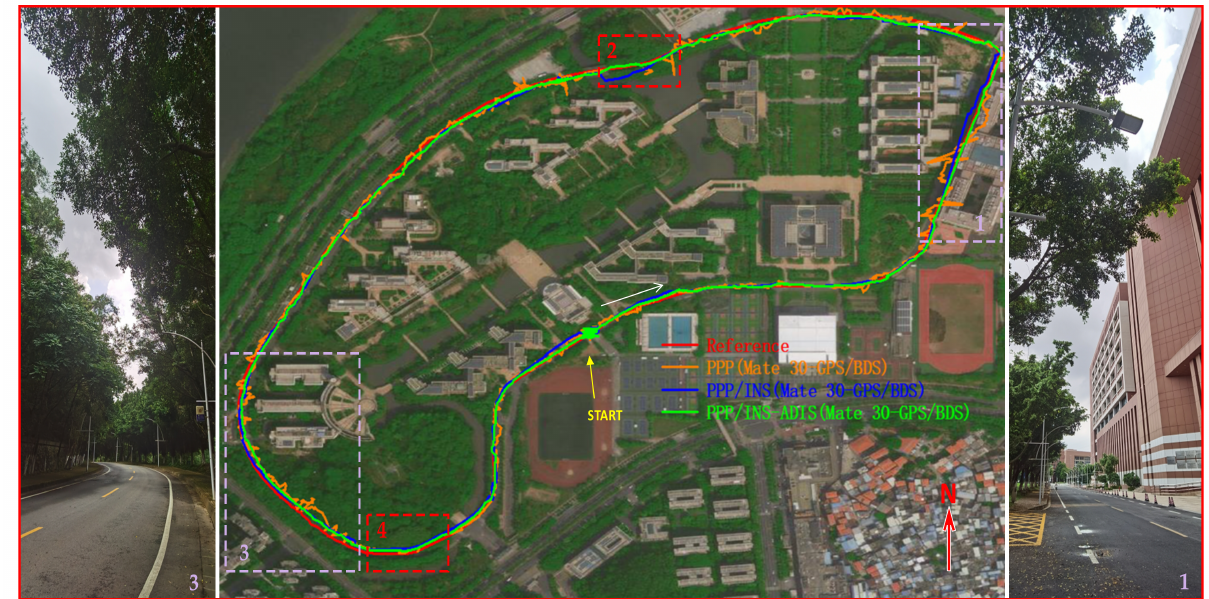
Figure 16. The long trajectories of GPS/BDS PPP, PPP/INS, and PPP/INS–ADIS solutions using Huawei Mate 30 and ADIS16405. Left: the realistic environment marked in the purple box 3. Right: the realistic environment marked in the purple box 1. The areas where the number of satellites cannot meet the requirements of GNSS positioning are marked by red boxes 2 and